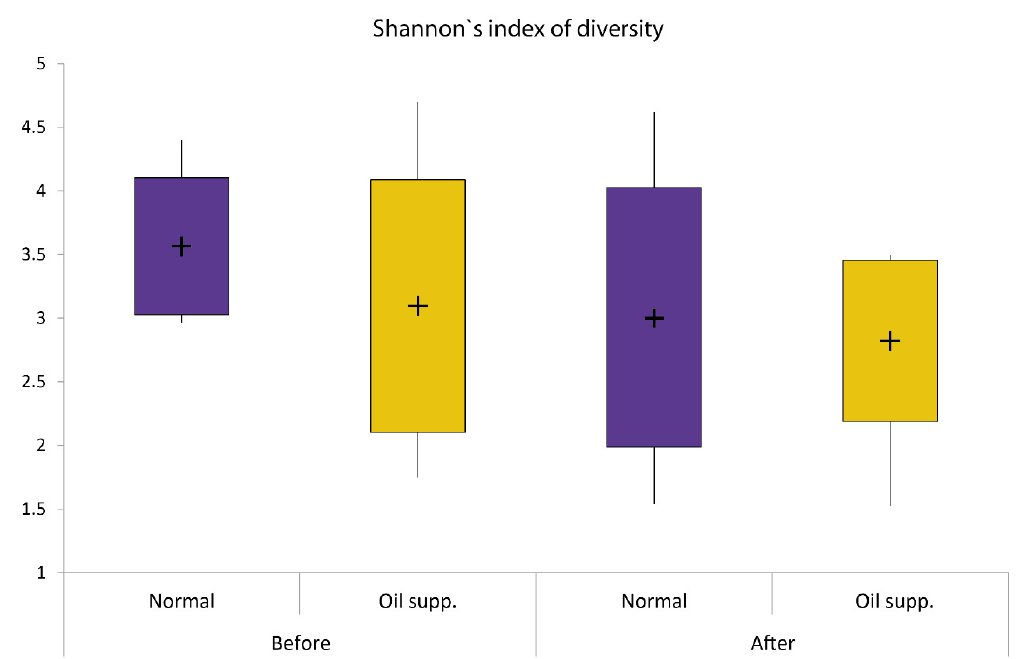
Figure 2. Bacterial phyla in the rectal swab of pigs fed a normal diet and a diet supplemented with coconut oil.